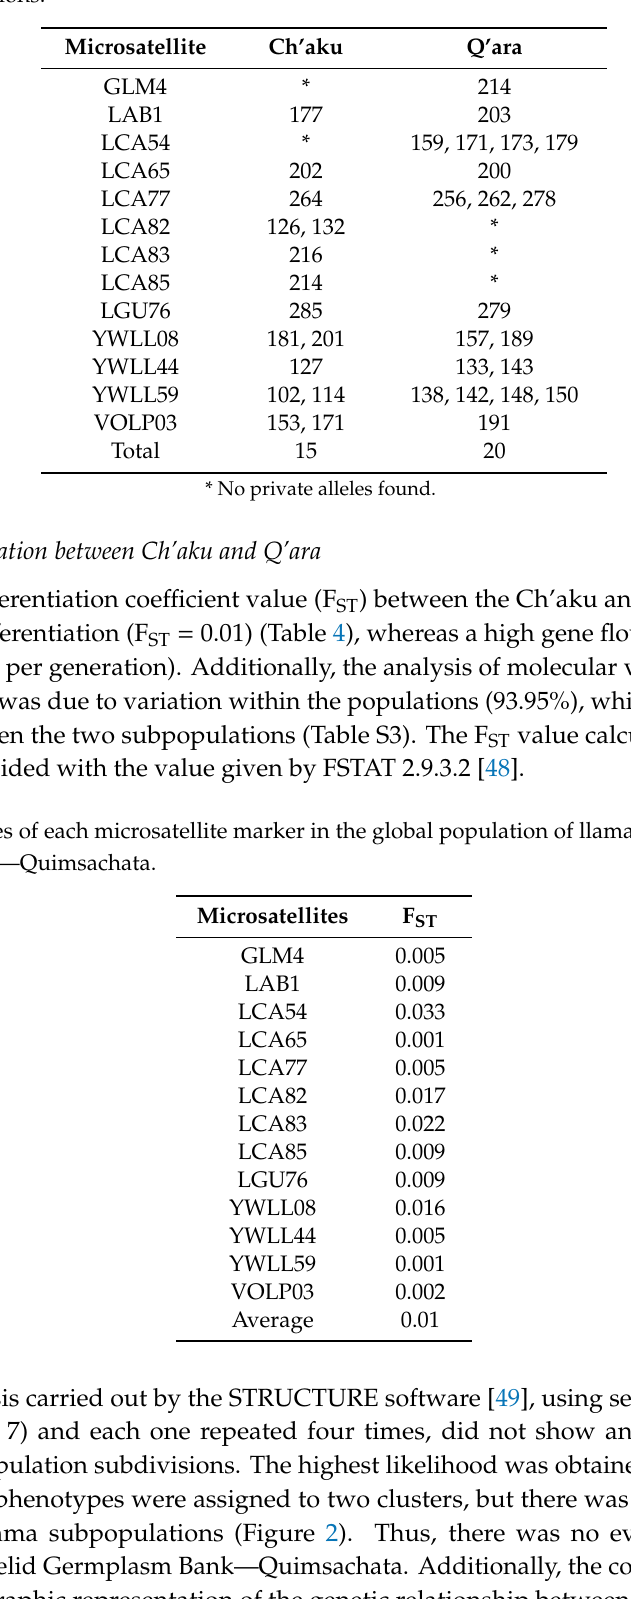
Table 3. Private allele size of the 13 analyzed microsatellite markers of the Ch’aku and Q’ara llama subpopulations.